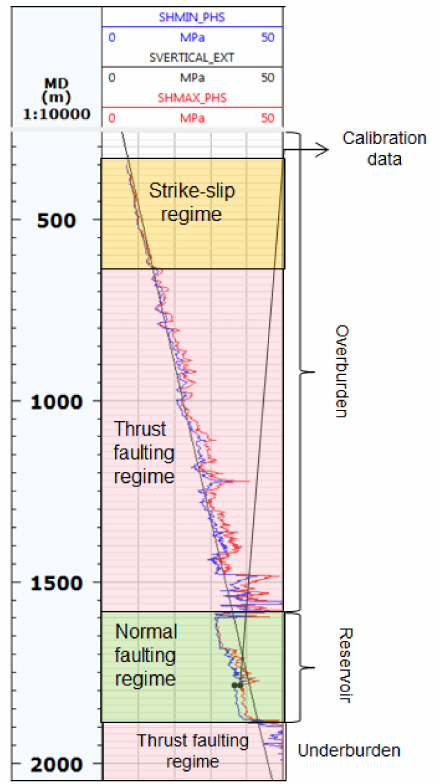
Figure 13. Calculated stress profile at well X6 showing vertical (SVERTICAL_EXT), maximum (SHMAX_PHS), and minimum horizontal (SHMIN_PHS) stresses with calibration data.